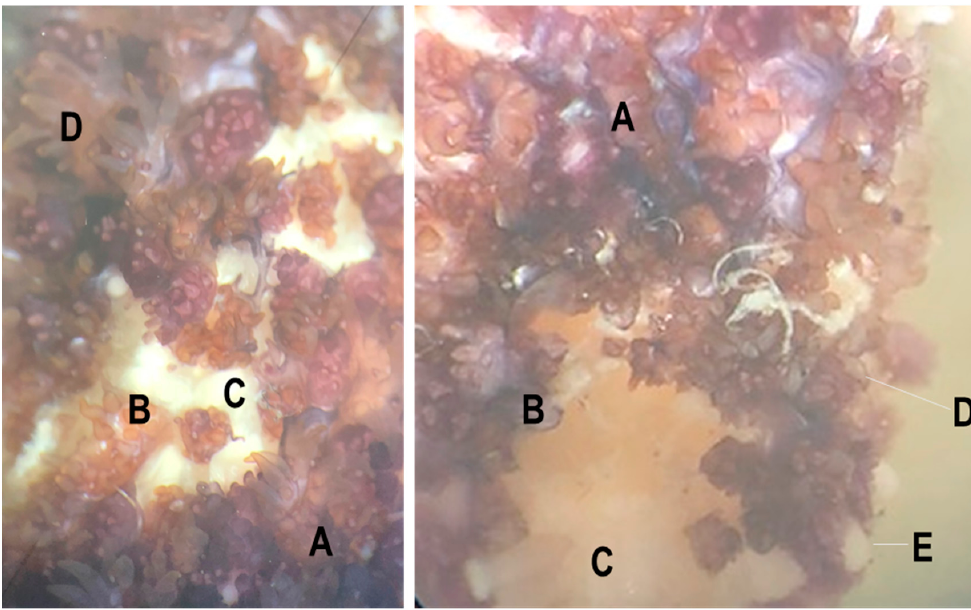
Figure 1. Gross examination of SSWD lesion on a Pisaster ochraceus specimen retrieved from Davenport, CA at the time of sampling for this survey. A = grossly normal tissue; B = lesion margin; C = lesion (underlying body wall tissues); D = papula and pedicellaria; E = paxilla (spine).